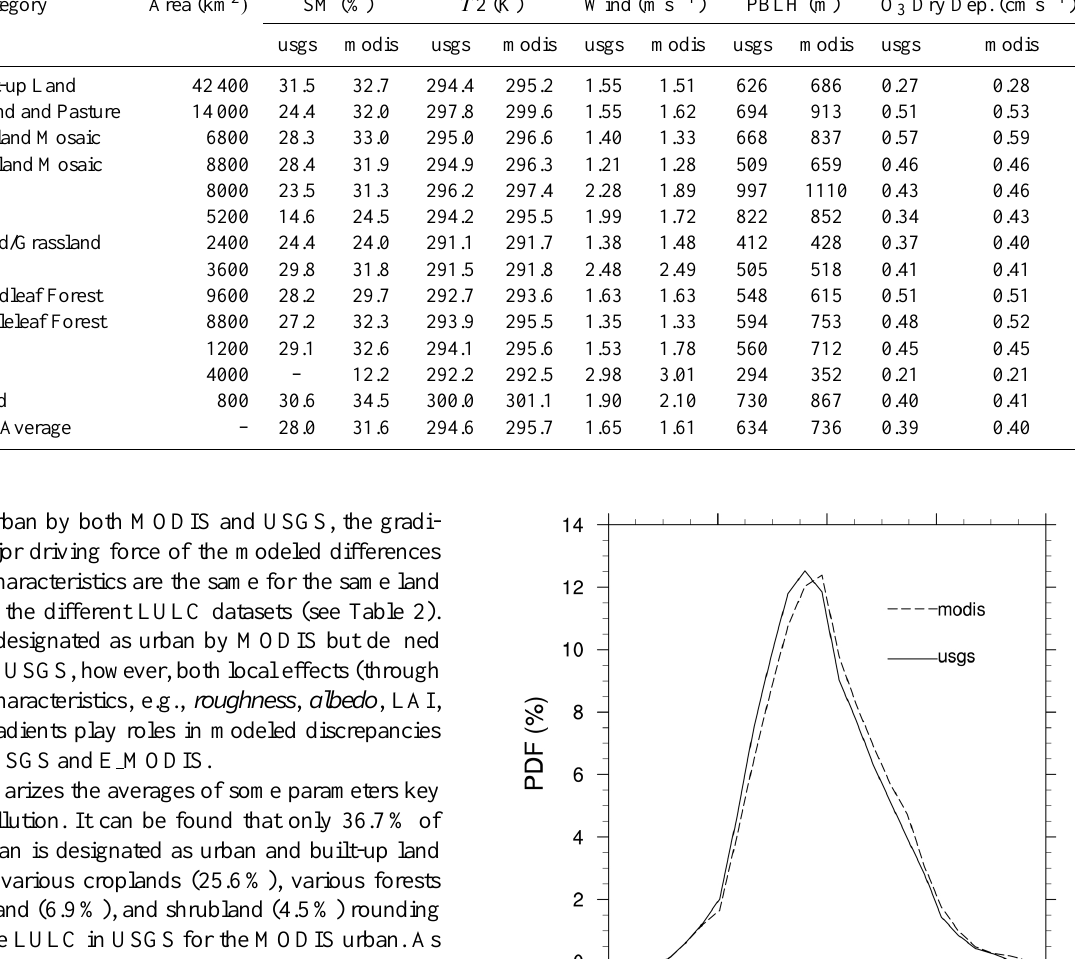
Table 4. Comparison of key parameters associated with urban ozone air quality over the MODIS urban areas. USGS Land Category